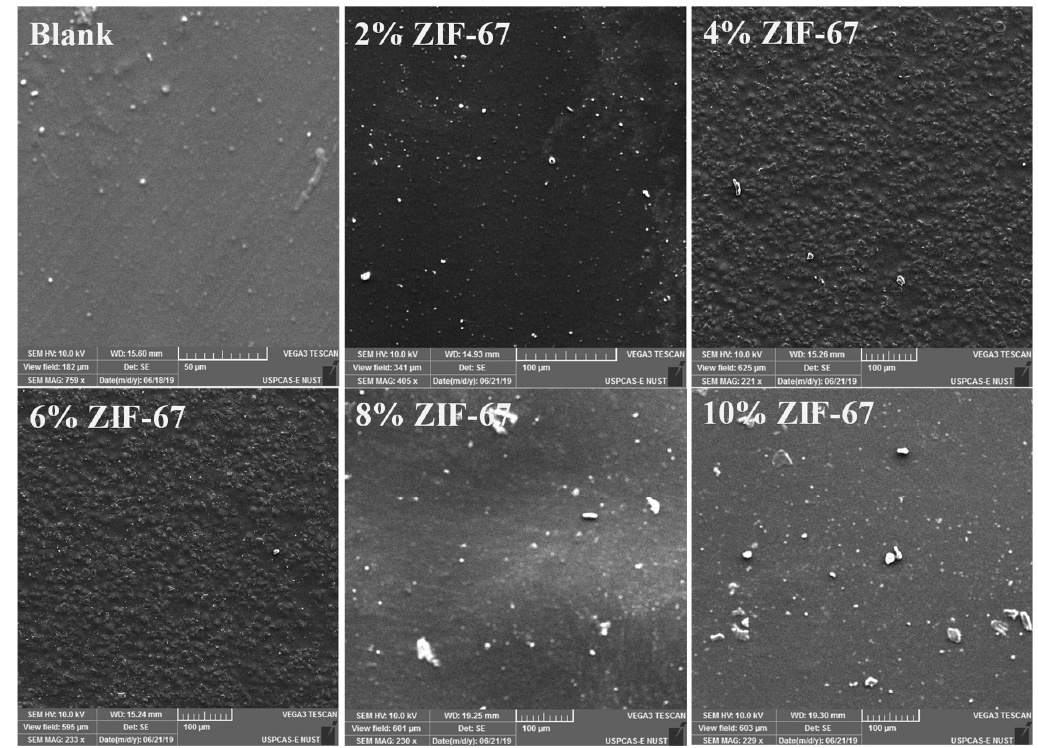
Figure 2. Surface morphology of PVA/starch nanocomposite films with various compositions of ZIF-67 SEM images: Blank, 2 wt.% ZIF-67, 4 wt.% ZIF-67, 6 wt.% ZIF-67, 8 wt.% ZIF-67, and 10 wt.% ZIF-67.